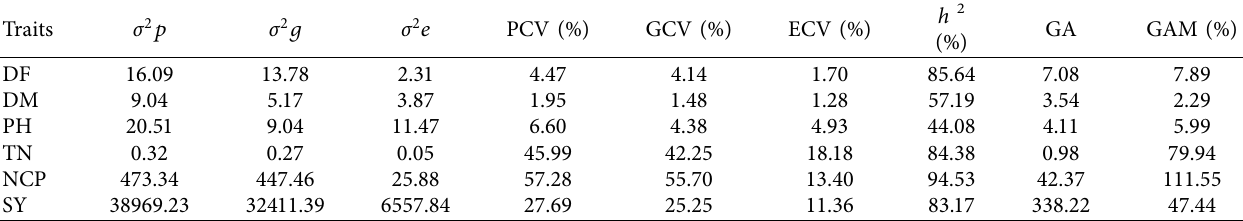
Table 5: Estimates of variance, coefcient of variation, broad sense heritability ( h 2 ), genetic advance (GA), and genetic advance as percent of the mean (GA%) of yield and related traits of linseed varieties grown over the two seasons (2019 and 2020).